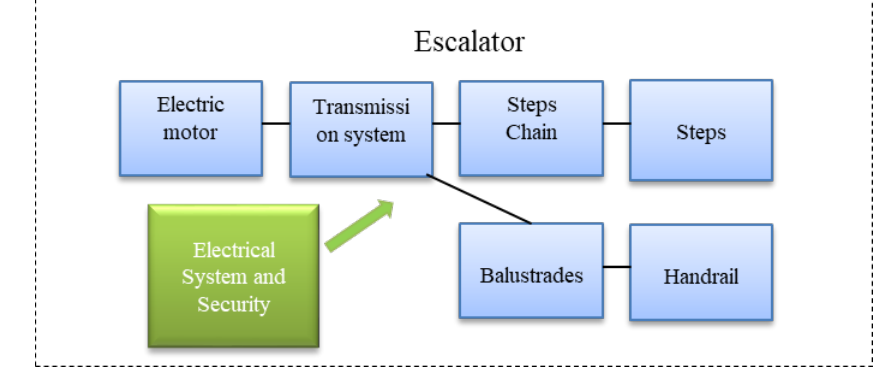
Figure 1. Building blocks of a TNE